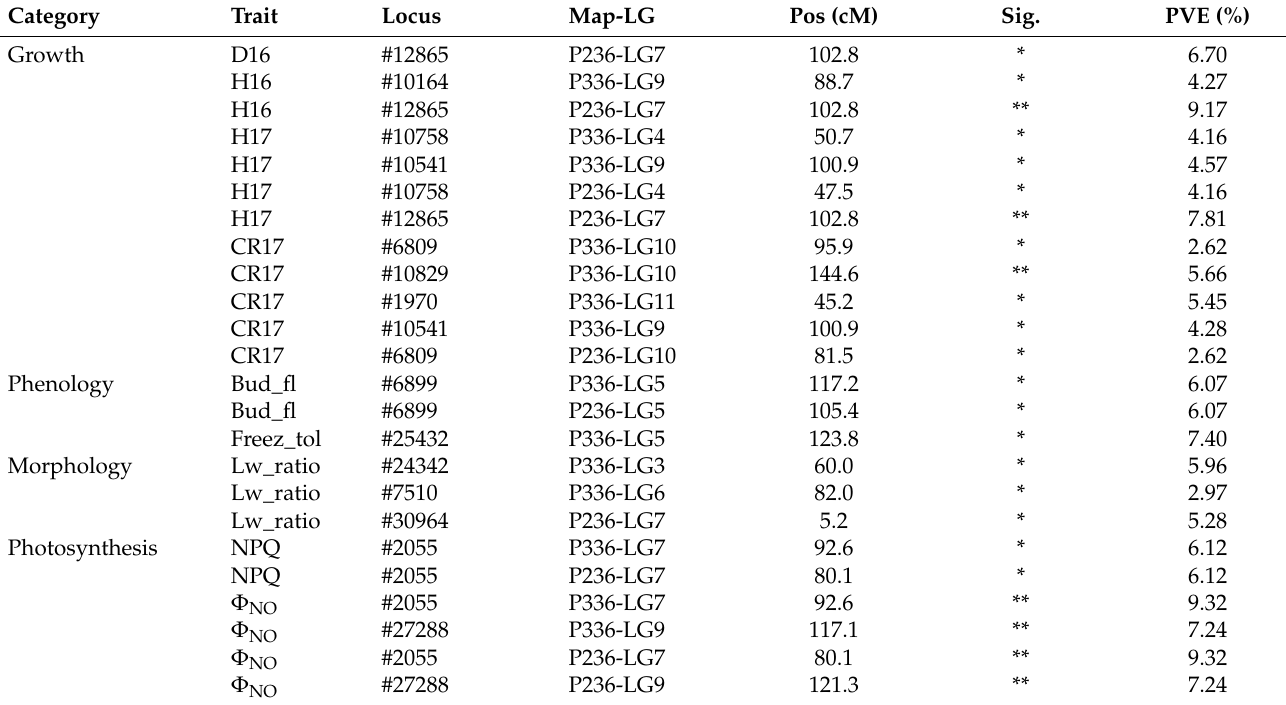
Table 4. The QTLs detected for each functional trait. The marker position (Pos.) and percentage variance explained (PVE) of each QTL are shown. The level of significance is presented in the Sig. column, with * 80% and ** 95% confidence intervals.